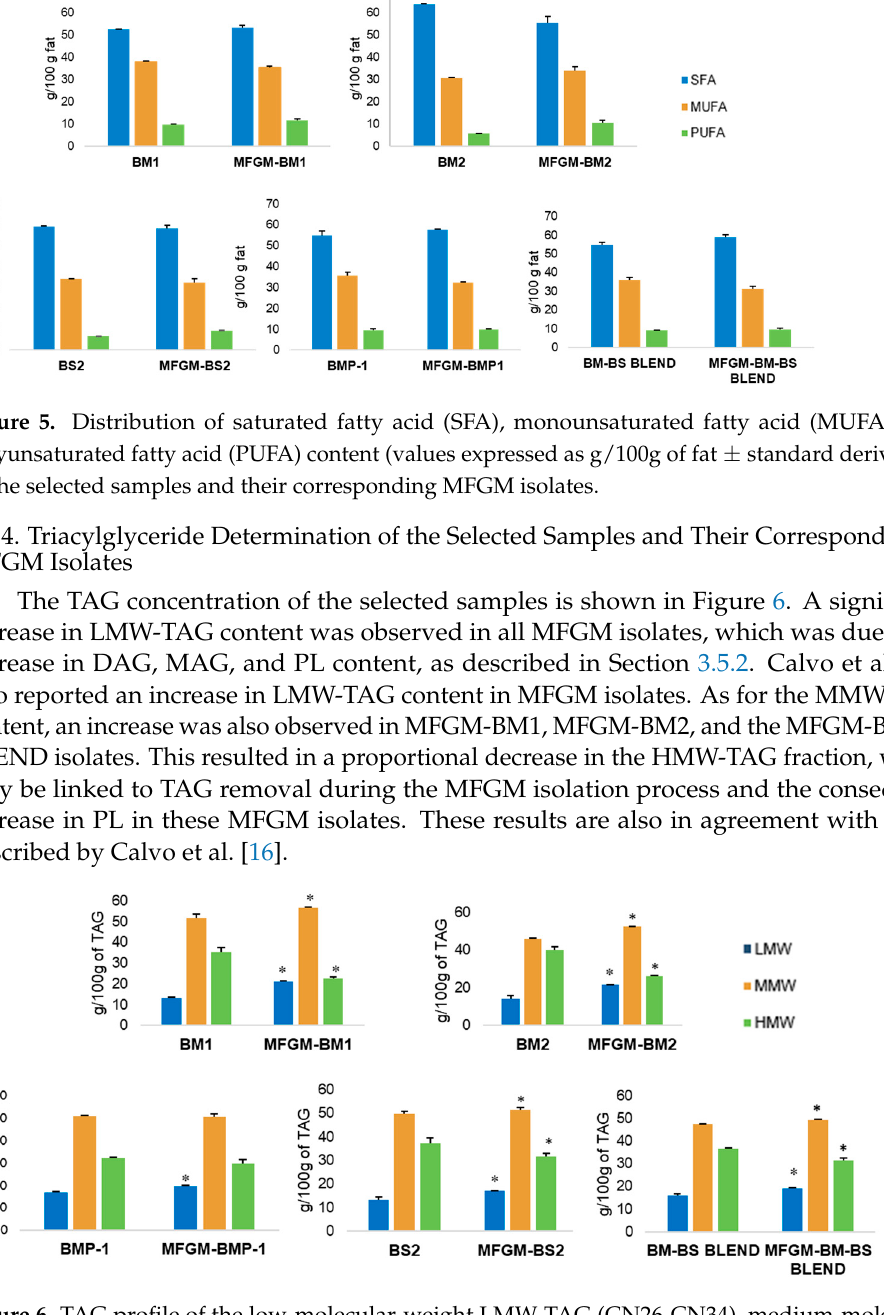
Figure 6. TAG profile of the low-molecular-weight LMW-TAG (CN26-CN34), medium-molecular-weight MMW-TAG (CN36-CN44), and high-molecular-weight HMW-TAG (CN46-CN-54) of the selected samples and their corresponding MFGM isolates. The data are expressed as means (g/100 g of fat ± standard deviation) of at least two replicates. * indicates significant differences ( p < 0.05).